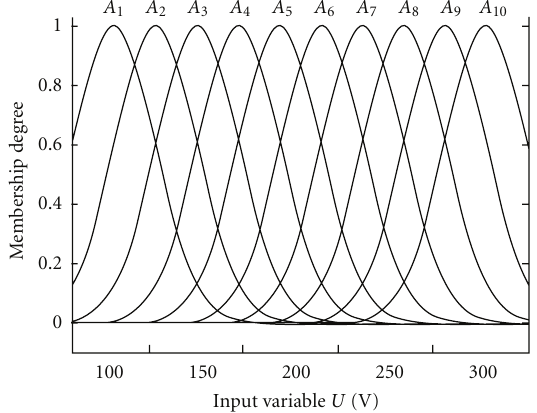
Figure 7: Comparison between model output and tested data ( Nre f = 30 r/min).